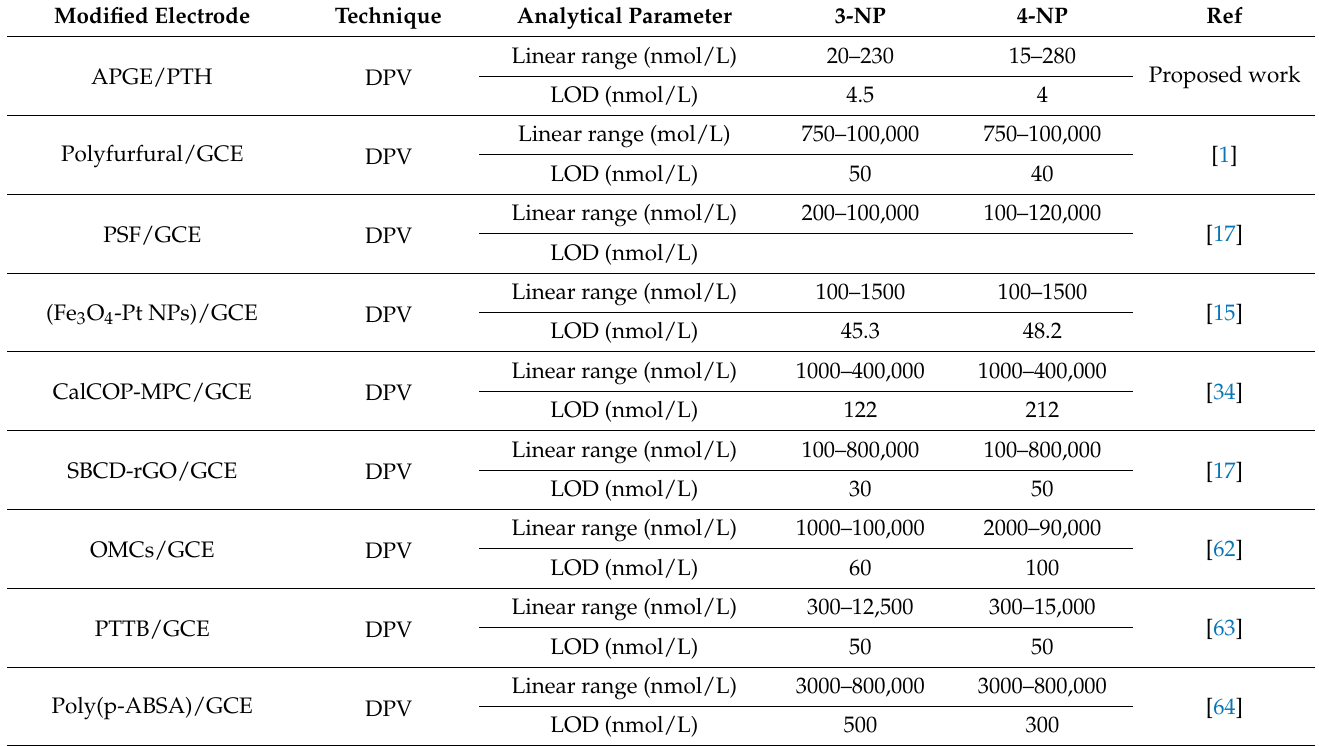
Figure 6. ( A ) DPV response of simultaneous sensing of 3-NP and 4-NP in various concentrations at 0.1 M PBS and ( B , C ) 3-NP and 4-NP concentration and corresponding cathodic current response calibration plot. Table 1. Analytical parameters comparison studies of the APGE/PTH with other reported